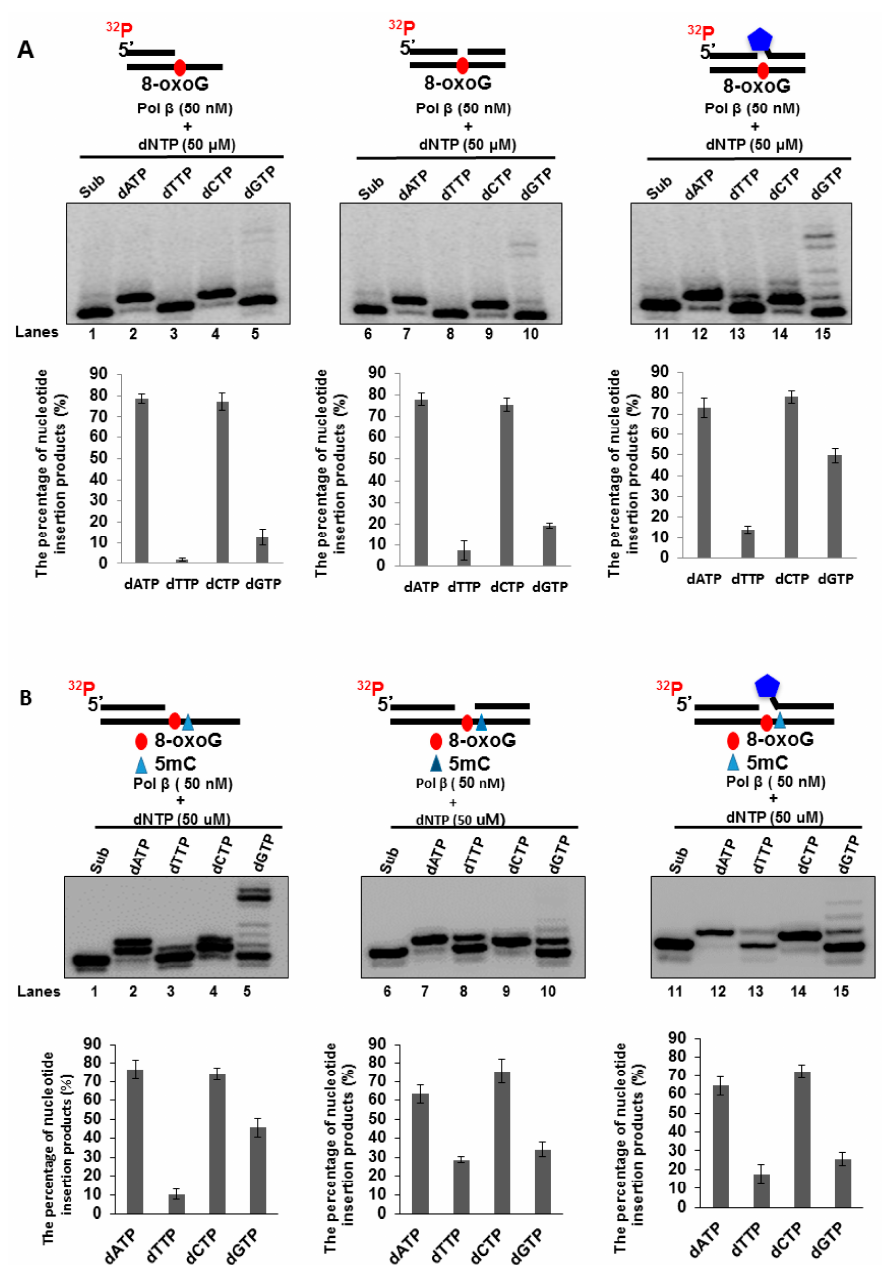
Figure 6. Pol β nucleotide insertion for bypassing an 8-oxoG: Bypass of an 8-oxoG by pol β was examined by incubating the open-template substrate and 1-nt gap substrates that contain a downstream 5 ′ -phosphate or 5 ′ -tetrahydrofuran (THF) residue and a template strand with 8-oxoG ( A ) and with both 5mC and 8-oxoG ( B ), with 50 nM pol β in the presence of 50 µM dATP or dTTP or dCTP or dGTP, respectively. Lanes 1, 6, and 11 represent substrate only. Lanes 2–5, 7–10, and 12–15 correspond to reaction mixtures with 50 nM pol β in the presence of 50 µM dATP or dTTP, or dCTP or dGTP. Substrates were 32 P-labeled at the 5 ′ -end of the upstream primer as indicated. Substrates are illustrated schematically above the gel. All experiments were done in triplicate. Quantification of the results is shown below the gels.